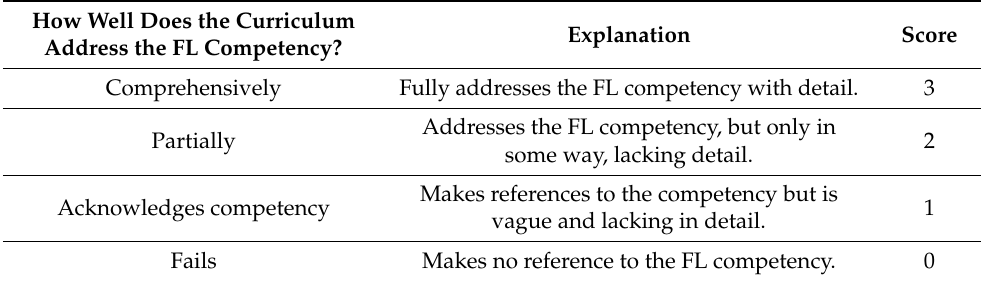
Table 3. Scoring guide. Source: authors.